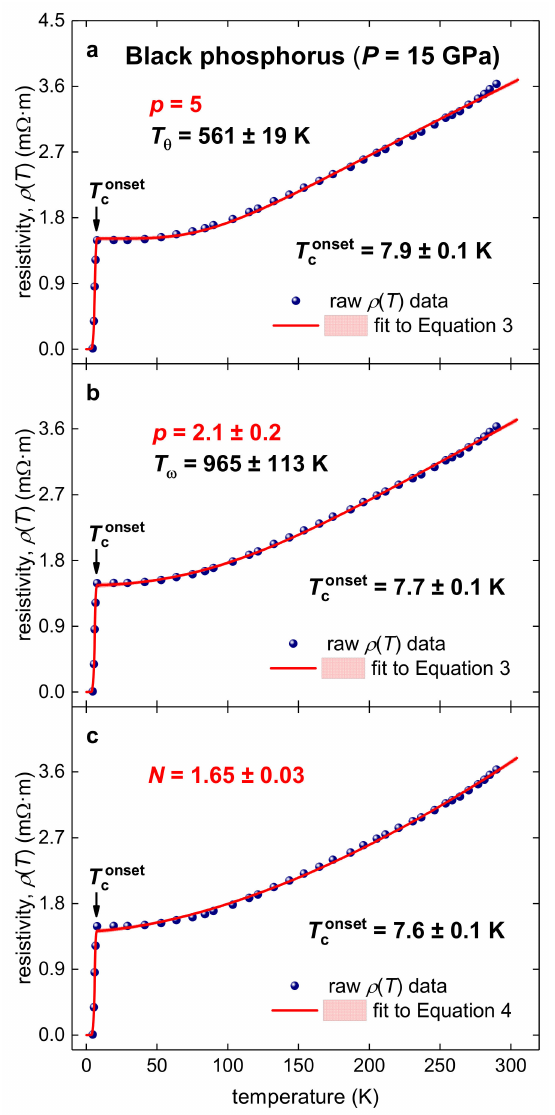
Figure 2. Resistivity data, ρ ( T ), and data-fits for Equation (3) for highly compressed black phospho- rus (raw data is from Reference [51]). ( a )—fit to Equation (3), p = 5, deduced T θ = 561 ± 19 K, T onset c = 7.9 ± 0.1 K, fit quality is 0.9986; ( b )—fit to Equation (3), deduced p = 2.1 ± 0.2, T ω = 965 ± 113 K, T onset c = 7.7 ± 0.1 K, fit quality is 0.9992; ( c )—fit to Equation (4), deduced N = 1.65 ± 0.03, T onset c = 7.6 ± 0.1 K, fit quality is 0.9989. Confidence bands at 95% are shown by pink shadow